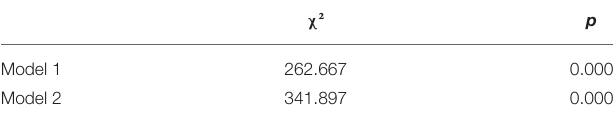
TABLE 4 | White heteroscedasticity results.